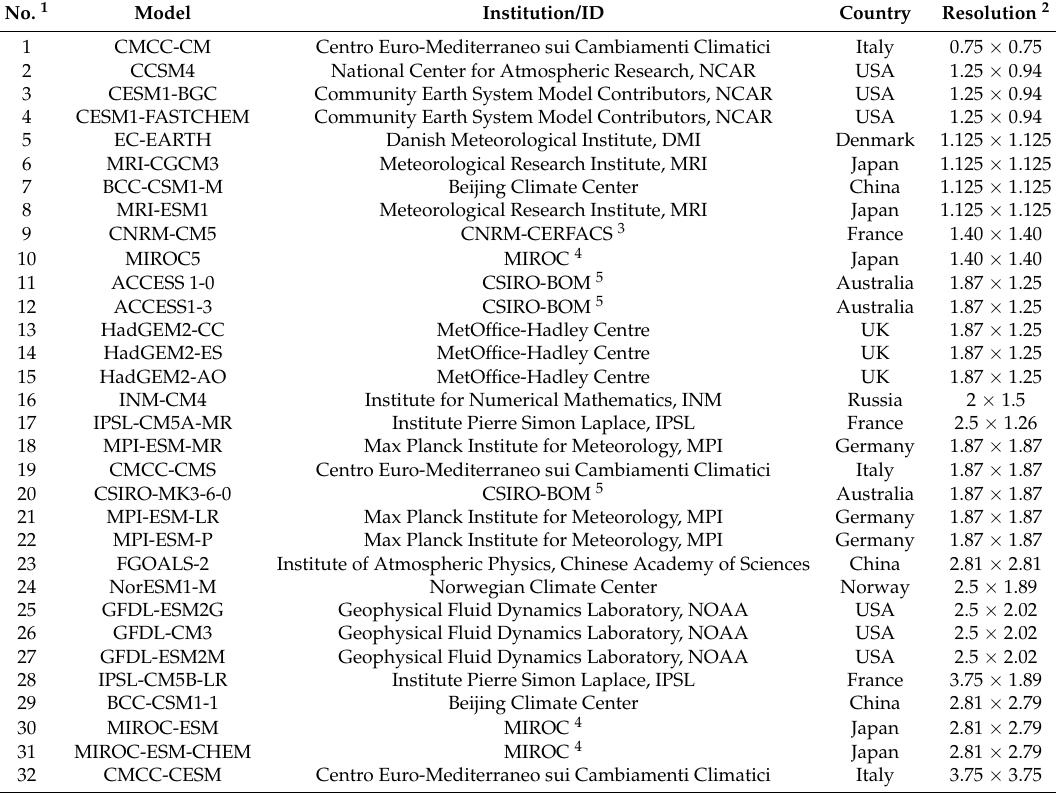
Table 1. List of CMIP5 Models Analysed. The order is decreasing in